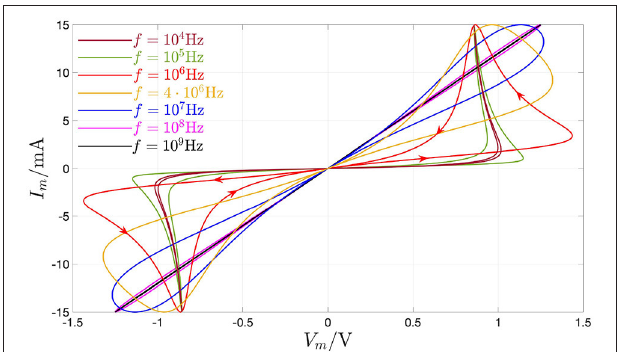
FIGURE 23 | Pinched hysteresis loops (Chua, 2014) of tangential type (Biolek et al., 2011), emerging at steady-state on the v m – i m plane under the application of an AC source, generating a sine wave current of the form i s =ˆ i s f t ) directly across the NbO memristor, for ˆ i s π sin(2 15mA, as the · · · · = frequency is stepped across the set of values 10 4 ,10 5 ,10 6 ,4 10 6 ,10 7 ,10 8 ,10 9 Hz. These results were obtained by { · } numerical simulation of the proposed polynomial-based DAE set (3) and (4), with g ( x , v m ) and G ( x ) expressed by Equations (5) and (6), respectively, and for an initial condition fixed to x 0 253.15. For the scenario associated to the = lowest input frequency in the aforementioned set, the locus resembles closely